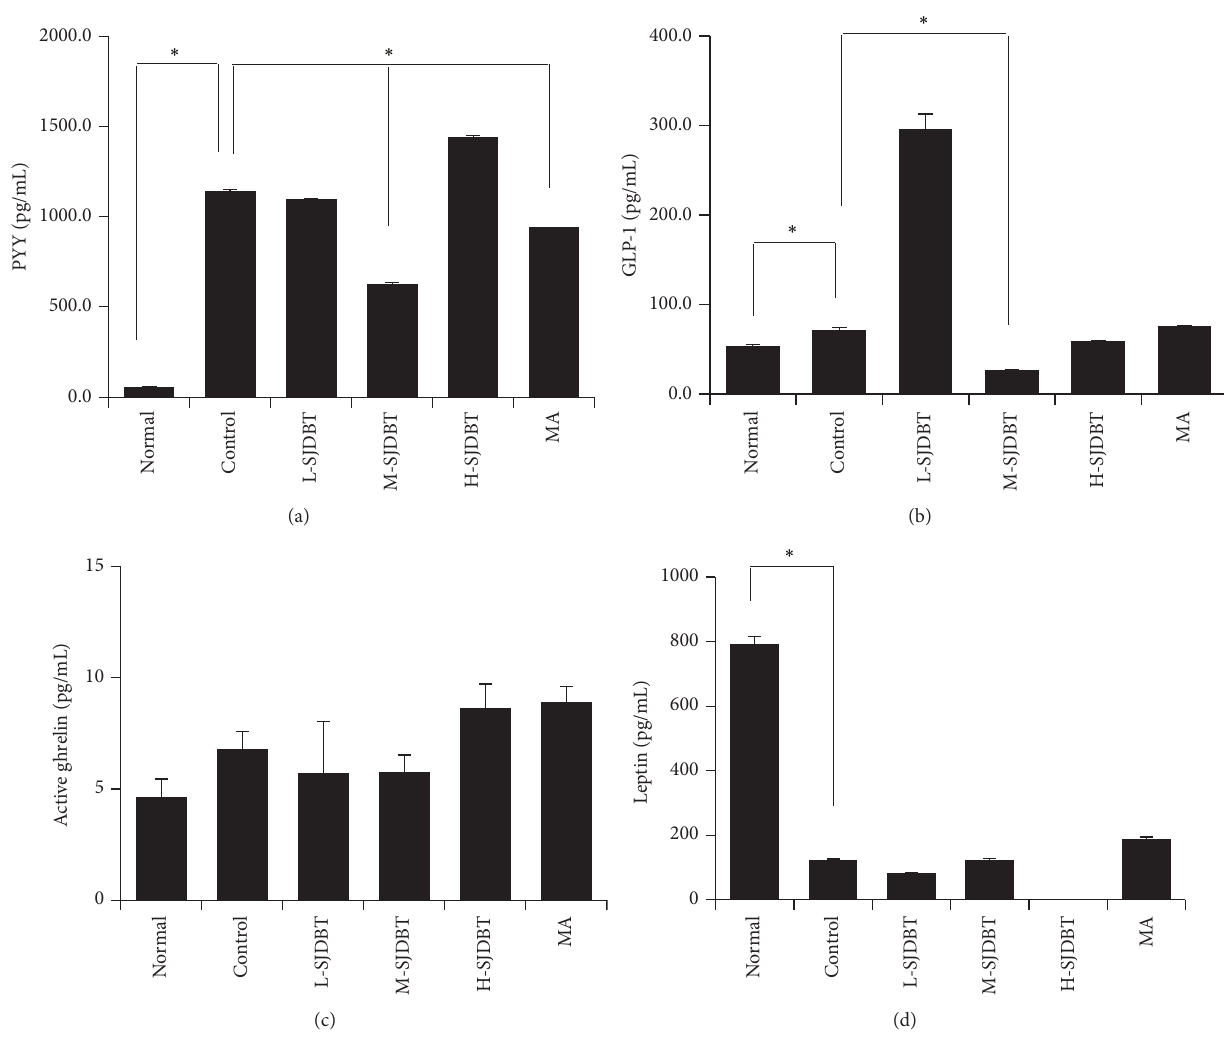
Figure 4: Effect of SJDBT on serums GLP-1, PYY, ghrelin, and leptin level in CT-26 tumor-bearing mice. ((a), (b)) 21 days after tumor cell injection, SJDBT were p.o. administrated for 21 days. At the end of experiments, mice were sacrificed. Blood samples were collected by cardiac puncture and serum samples were obtained blood sample after centrifuged. GLP-1, PYY, ghrelin, and leptin level were measured using a Milliplex Mouse Metabolic Magnetic Bead Panel MMHMAG-44K-14. Experiments were performed in duplicate. Bars indicate means and standard deviations. ∗ 𝑃 < 0.05